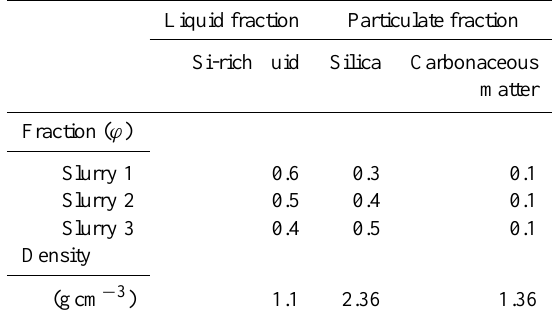
Table 3. Composition of the three slurries used for the rheological model of Fig. 16.